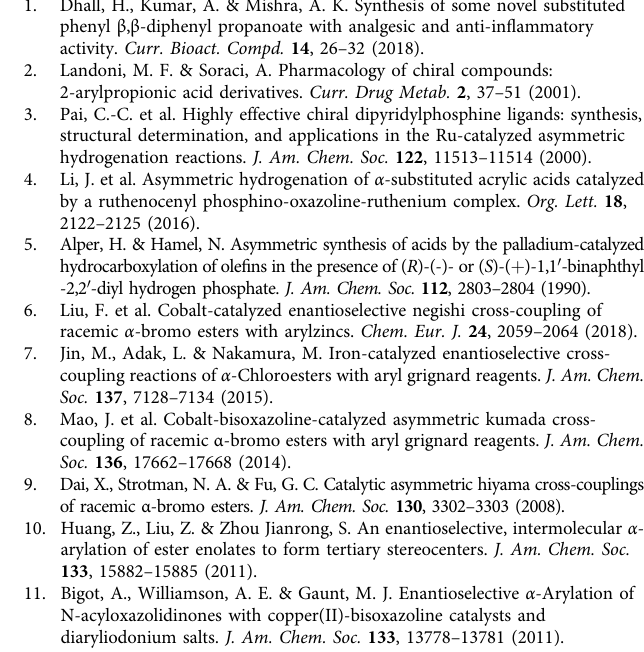
General procedure 2 . To an oven-dried vial equipped with a stir bar was added NiCl 2 (cid:129) glyme (2.2mg, 0.01mmol), L6 (5.4mg, 0.011mmol) and acetone/DMA (2.0/1.0, v/v, 3.0mL) under an argon atmosphere inside a glove box at RT, giving a light green solution. After 30min at RT, tert -butyl acrylate (0.1mmol, 1.0 equiv.), 1° or 2°-alkyl iodides (0.4mmol, 4.0 equiv.), 1-(4-iodophenyl)ethan-1-one (0.2mmol, 2.0 equiv.), Cy 2 NMe (58.5mg, 64 μ L, 0.3mmol, 3.0 equiv.), HEH (75.9mg, 0.3mmol, 3.0 equiv.) and 4CzIPN (8.0mg, 0.01mmol) were added. Once HEH and 4CzIPN were added, the